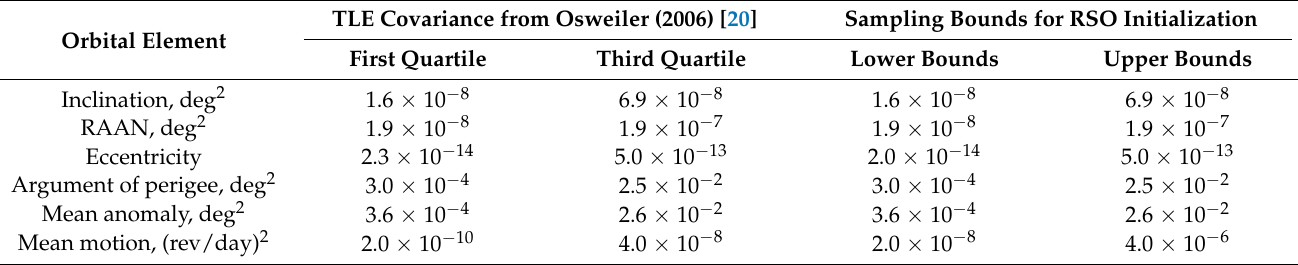
Table 2. Sampling bound for diagonal of RSO